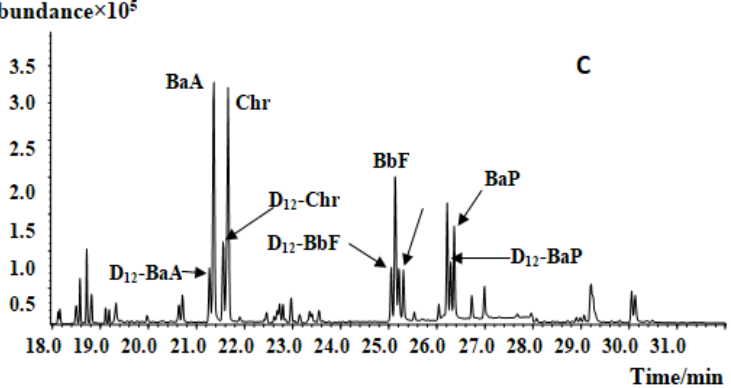
Figure 2. Mass chromatogram of Lotus leaf extract before and after SPE purification: ( A ) before purification; ( B ) after FLORISIL SPE purification; ( C ) after FLORISIL and EUPAH SPE columns purification.